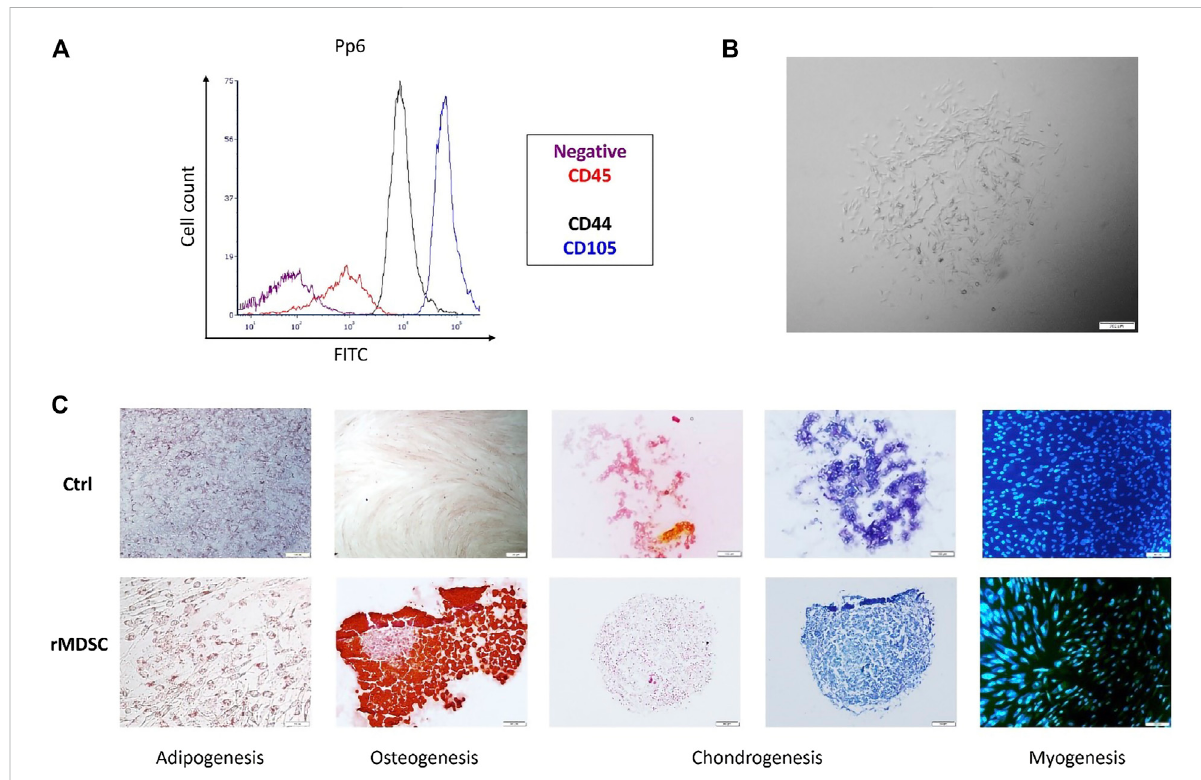
FIGURE 2 Characterization of isolated rMDSCs. The expression of speci fi c stem-cell markers of preplate 6 (pp6) was tested via FACS (A) . Pp6 was differentiated into adipocytes, osteocytes, chondrocytes, and myocytes (C) . Isolated cell (preplate 6; passage 5) morphology was identi fi ed via microscopy (B) . (A) purple color — negative control, red — CD45, black — CD44, and blue — CD105; (C) adipogenesis — Oil Red O staining; osteogenesis — Alizarin red staining; chondrogenesis — safranin O (orange-red) and toluidine blue (blue) staining; myogenesis — DAPI (blue)